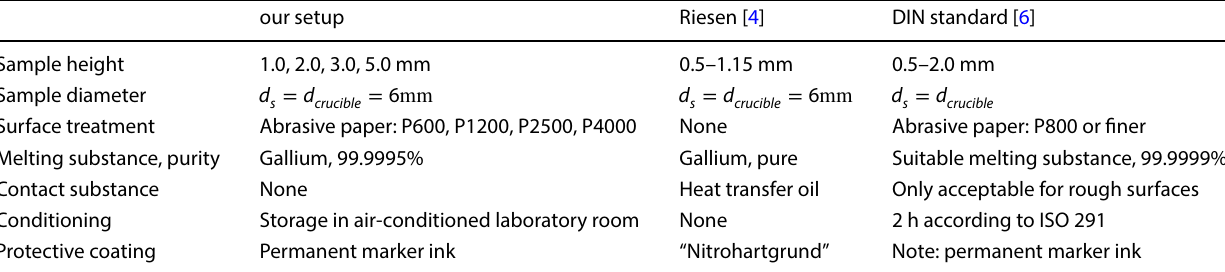
Table 1 Comparison of the different implementations of the thermal conductivity measurement with DSC our setup Sample